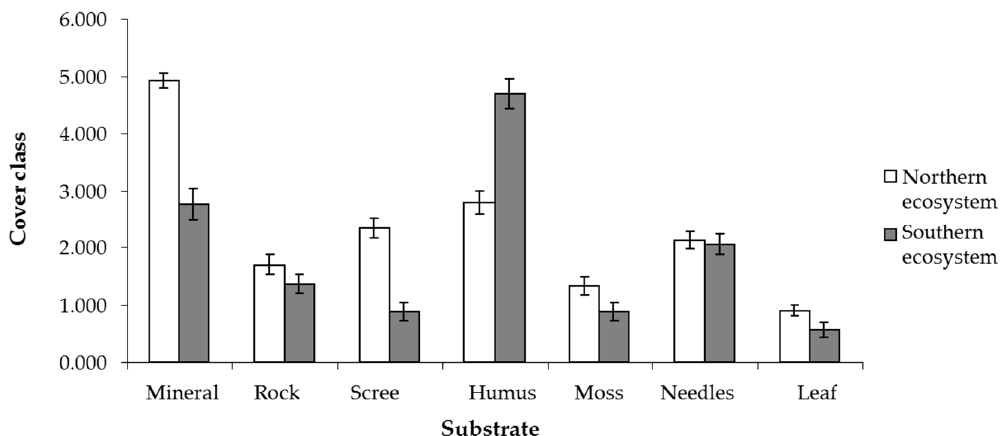
Figure 3. Abundance of substrates by cover classes in mature limber pine stands in northern and southern ecosystems (mean ± 1 s.e., n = 9 and 8 study stands, respectively). Percent cover classes were: 1: ≤ 1%, 2 = 2% – 5%, 3 = 6% – 10%, 4 = 11% – 25%, 5 = 26% – 50%, 6 = 51% – 75%, and 7 = 76% – 100%.